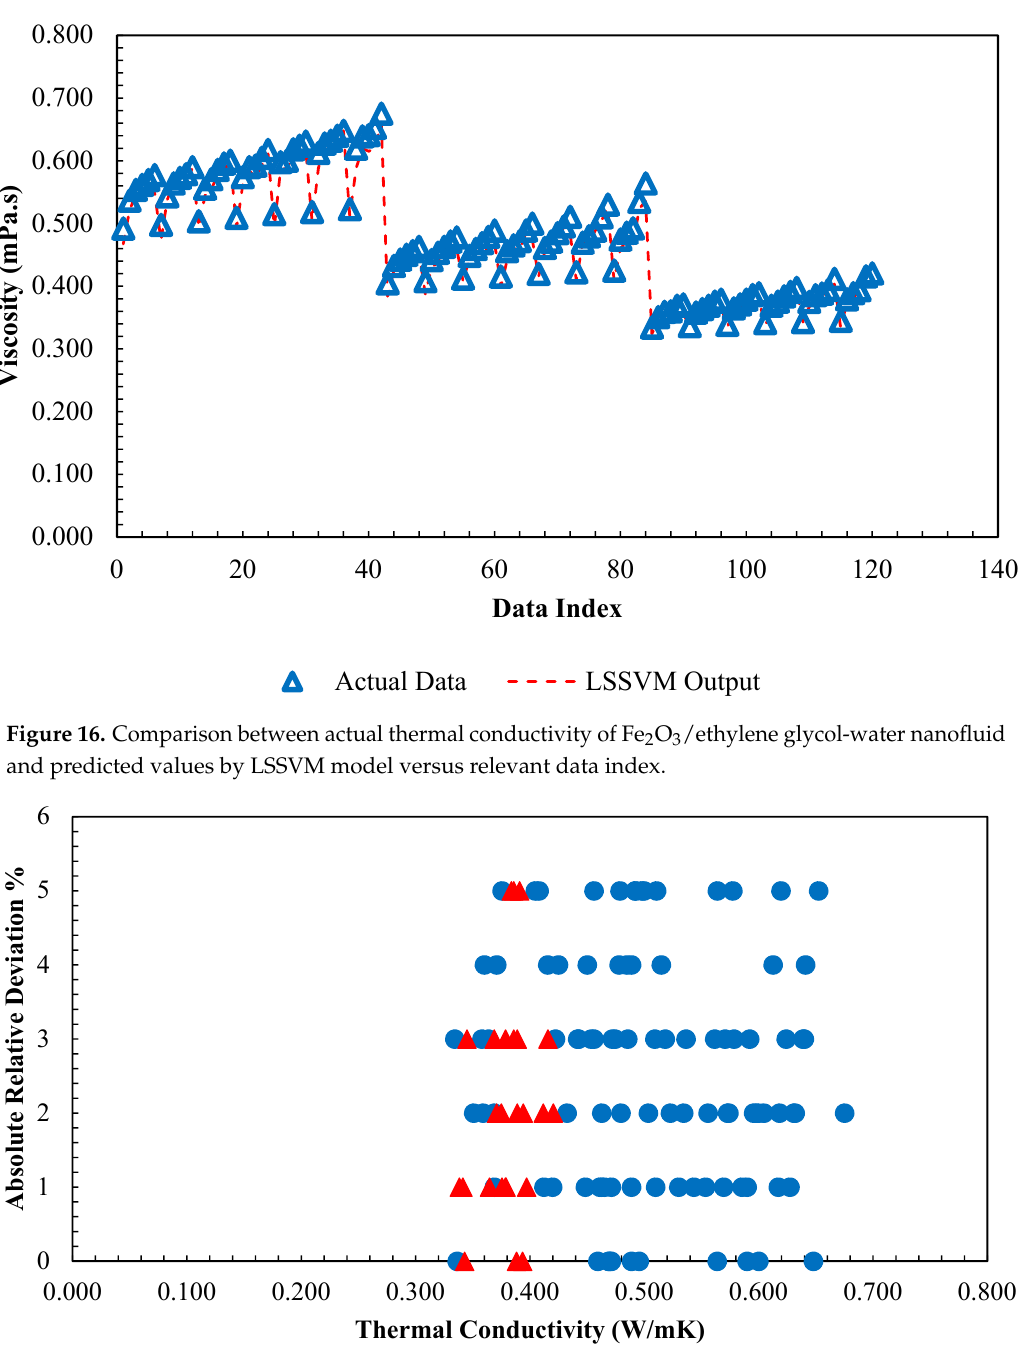
Figure 17. Absolute relative error distribution of the obtained outputs from LSSVM model versus corresponding thermal conductivity of (cid:1832)(cid:1857) (cid:2870) (cid:1841) (cid:2871) /ethylene glycol ‐ water nanofluid data points.